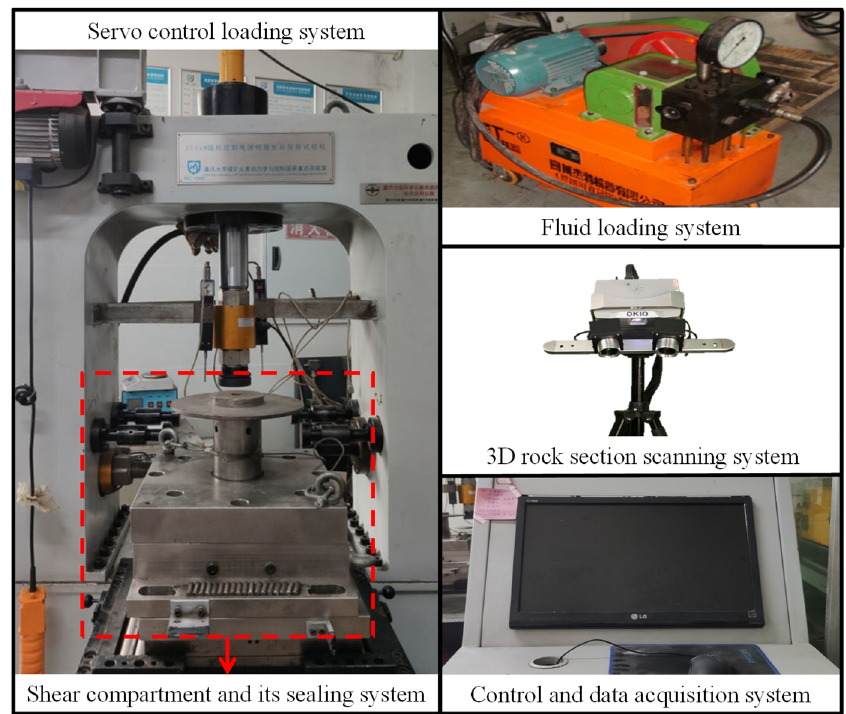
Figure 2. Device used for the shear flow coupling